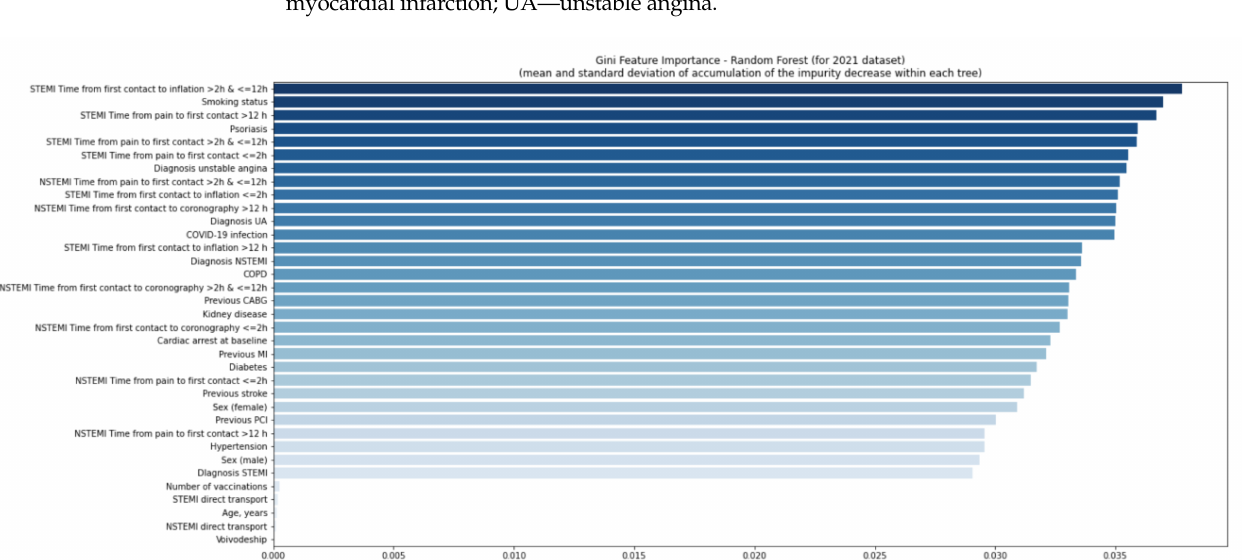
Figure 6. Gini feature importance analysis for patients in 2020. The diagram shows the mean decrease of the model’s impurity. In the analysis, each feature’s importance is calculated as the sum over the number of splits across all trees, which includes the features proportional to the number of samples in the split. In the random forest model, the variable is considered important if the tree split on this variable is affected by large impurity (labels homogeneity in the node) and decreases. CABG—coronary artery bypass graft; COPD—chronic obstructive pulmonary disease; MI—myocardial infarction; NSTEMI—non-ST-elevation myocardial infarction; PCI—percutaneous coronary intervention; Q—quartile; STEMI—ST-elevation myocardial infarction; UA—unstable angina.